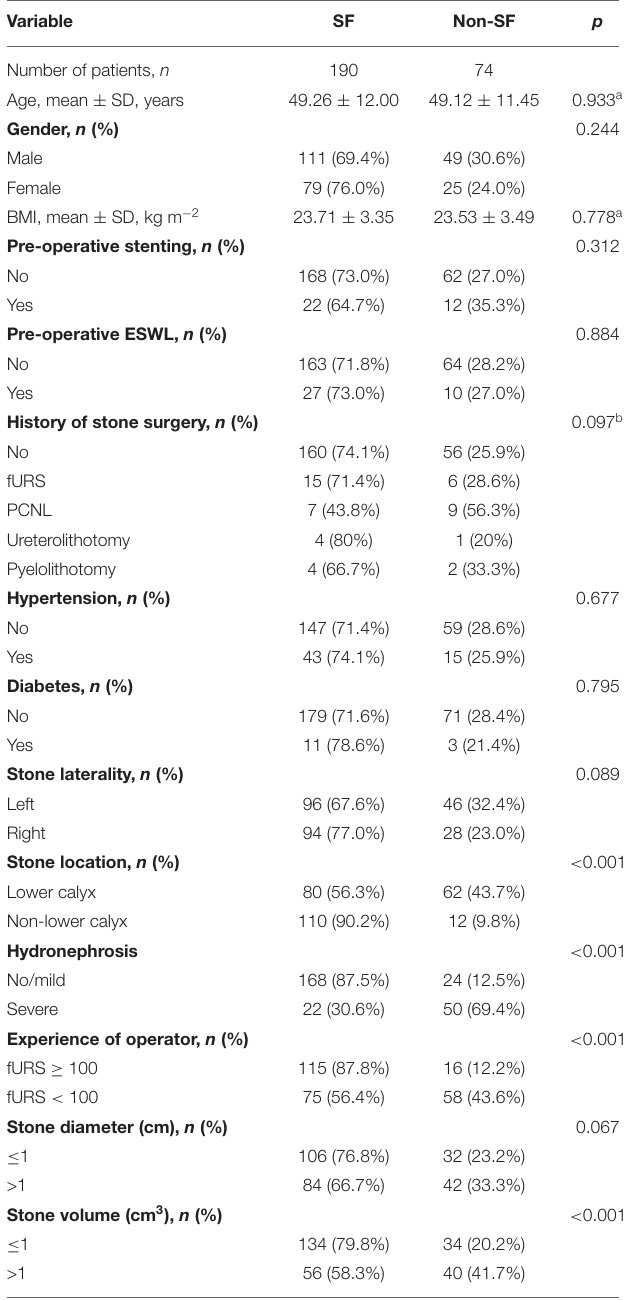
TABLE 1 | Comparison of single kidney stone patient and stone characteristics according to SF at 3 months after fURS.